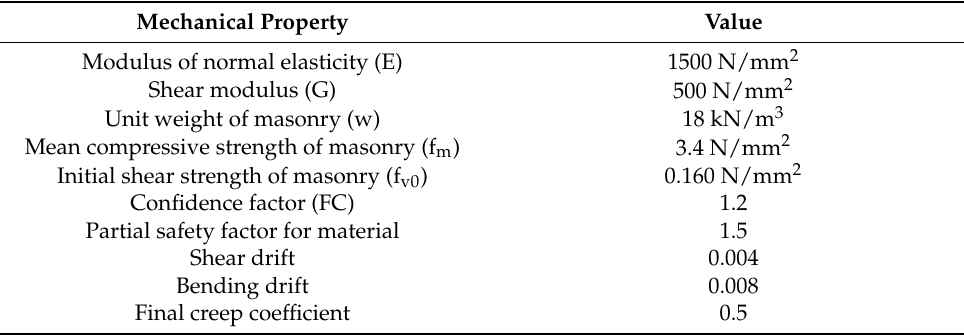
Table 1. Mean values for mechanical properties of solid brick masonry and lime mortar. Mechanical Property